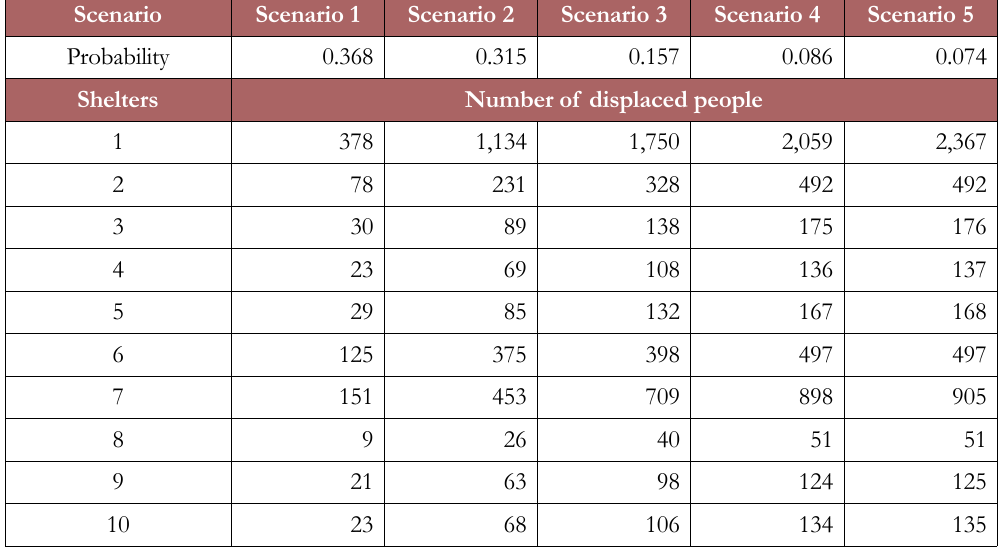
Table 2. Occurrence probability of each scenario